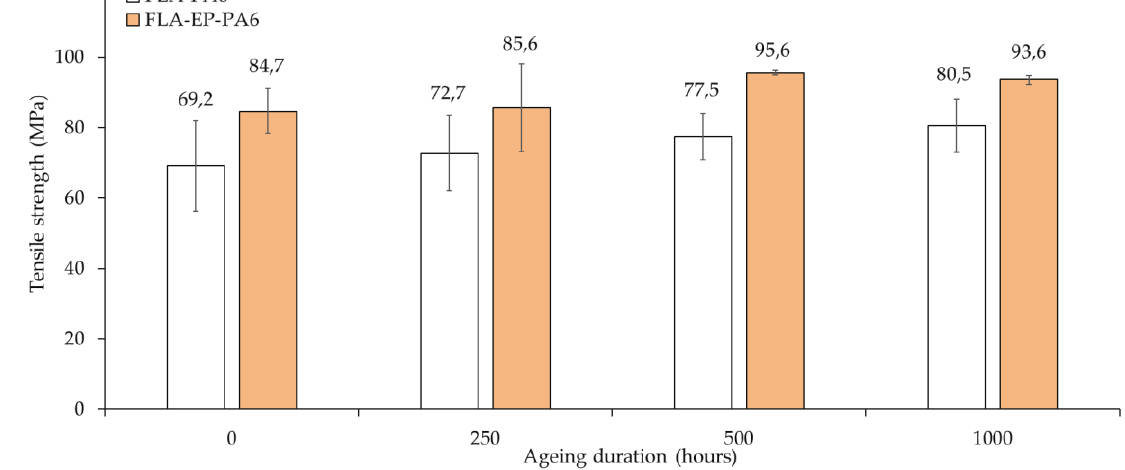
Figure 6. Tensile strength of the biocomposites at ambient conditions.